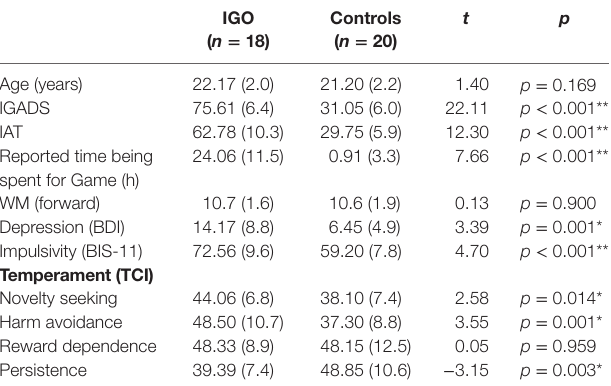
TaBle 1 | Demographic characteristics of